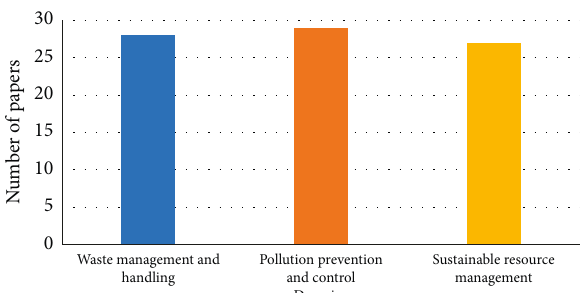
Figure 3: Statistics of the papers based on the environmental sustainability domains.